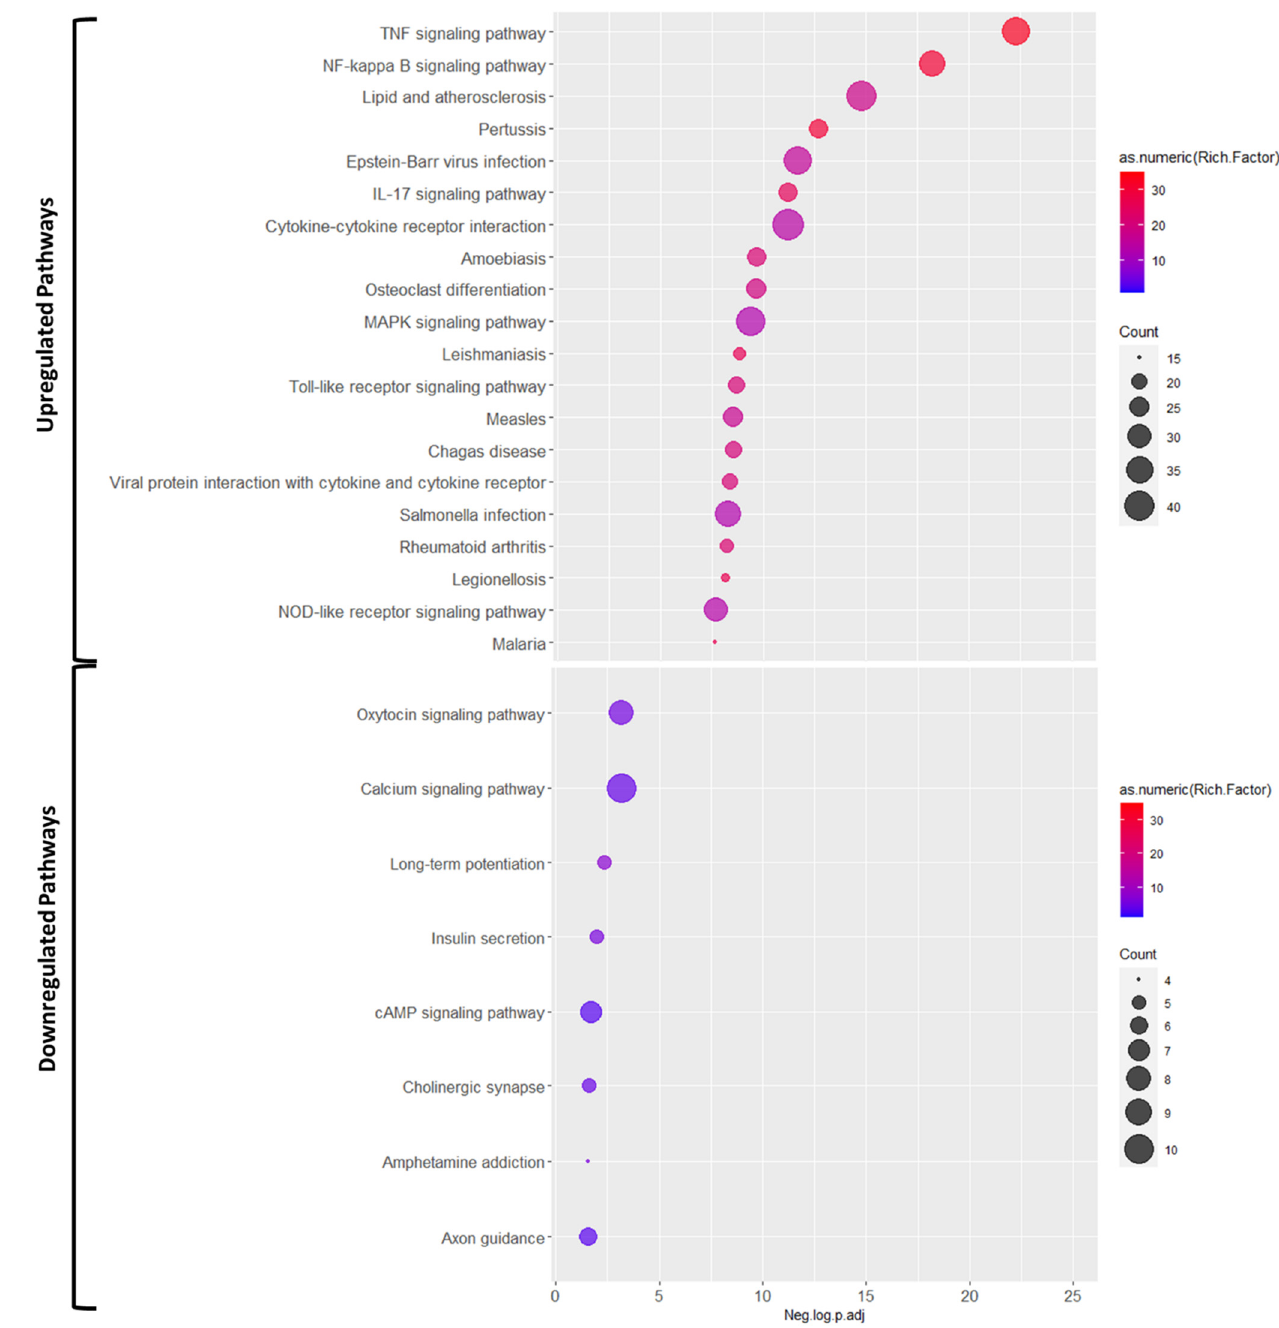
Figure 3. The results of KEGG enrichment pathway for upregulated and downregulated DEGs for IR condition (list of all significant terms can be found in Table S12 and S13).